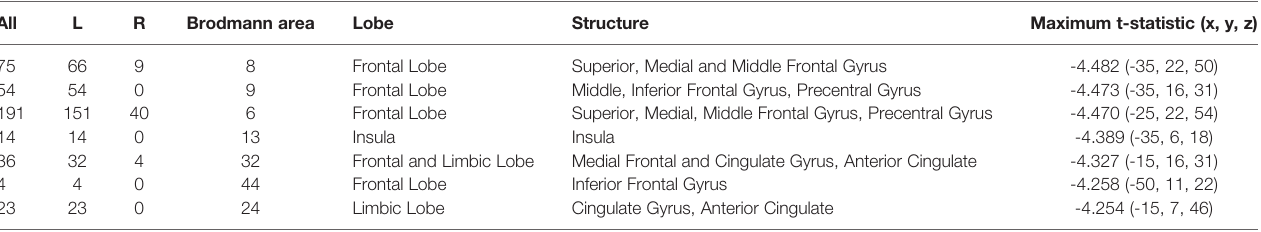
TABLE 3 | Number of voxels, Brodmann areas and anatomical region where signi fi cant differences in baseline standardized low-resolution brain electromagnetic tomography (sLORETA) current density were found for beta-1 frequency band (12.5 – 18 Hz), comparing responders and non-responders to repetitive transcranial magnetic stimulation (rTMS)